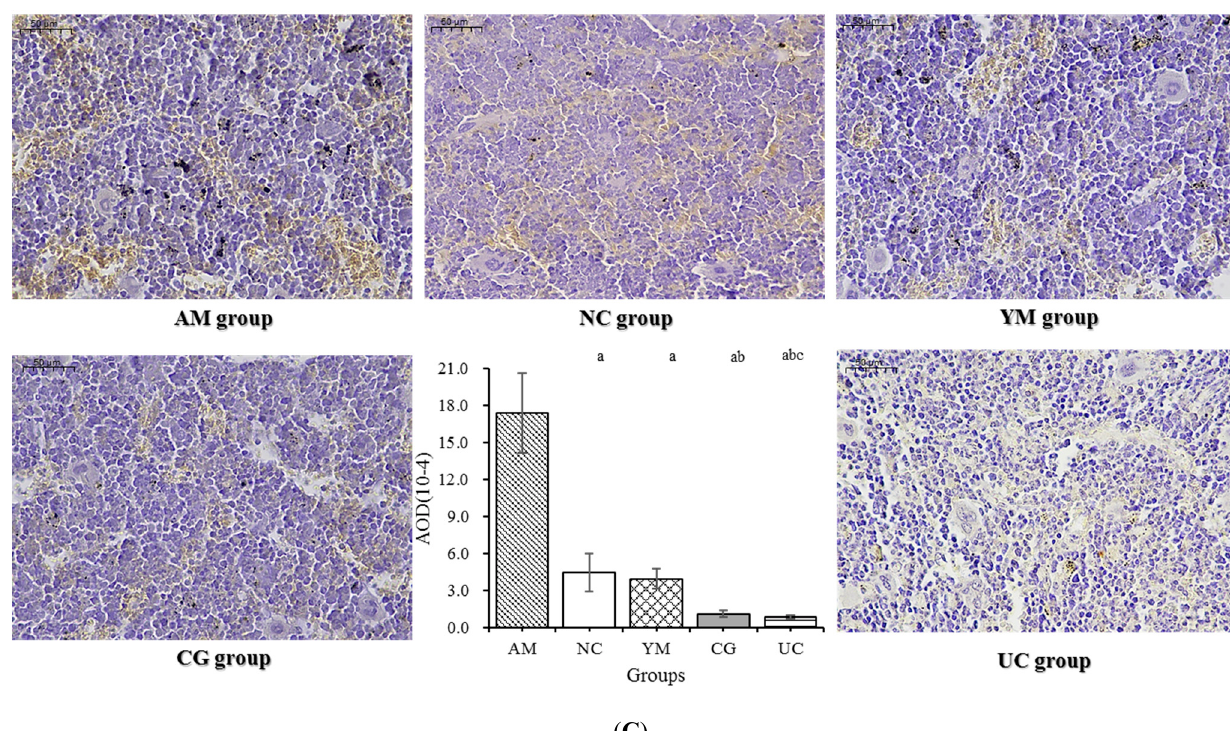
Figure 6. Immunohistochemistry analysis of the five groups. Magnification: ×400. IHC quantification is shown in the bar graphs. ( A ) Protein expressions of IL-1 β in the femur; ( B ) protein expressions of RANKL in the femur; ( C ) protein expressions of TRAP in the femur. The data are the means ± SD ( n = 5, 7, 9, 9, and 10 in the AM, CG, UC, NC, and YM groups); a p < 0.05 versus the AM group, b p < 0.05 versus the NC group, c p < 0.05 versus the YM group, d p < 0.05 versus the CG group.